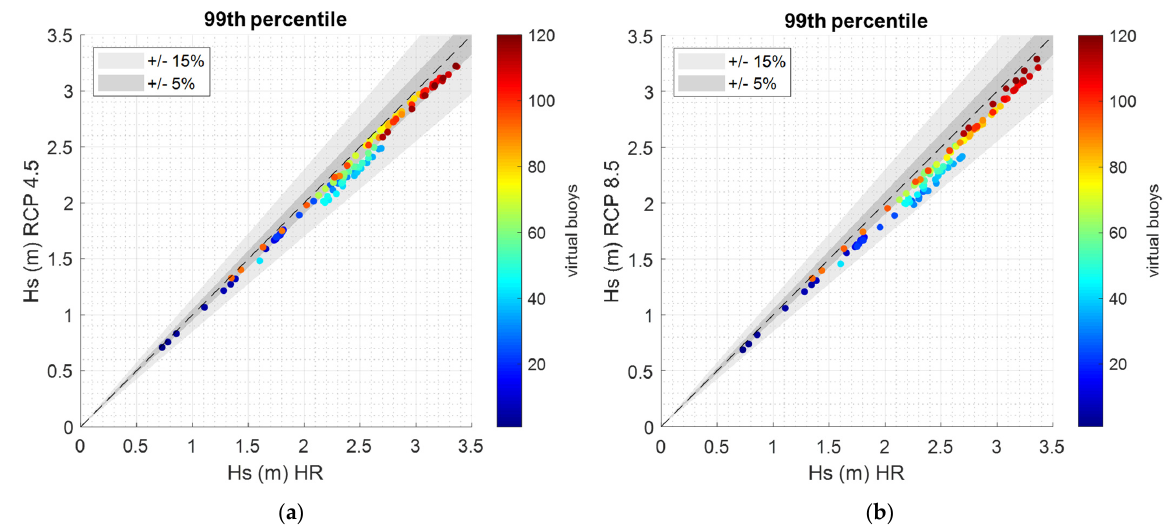
Figure 4. Comparison between the 99th percentiles of the significant wave heights Hs computed at the 120 virtual buoys along the Italian Adriatic coast relative to the historic run (HR) and future scenario runs: ( a ) historic run vs. RCP 4.5 scenario; ( b ) historic run vs. RCP 8.5 scenario.